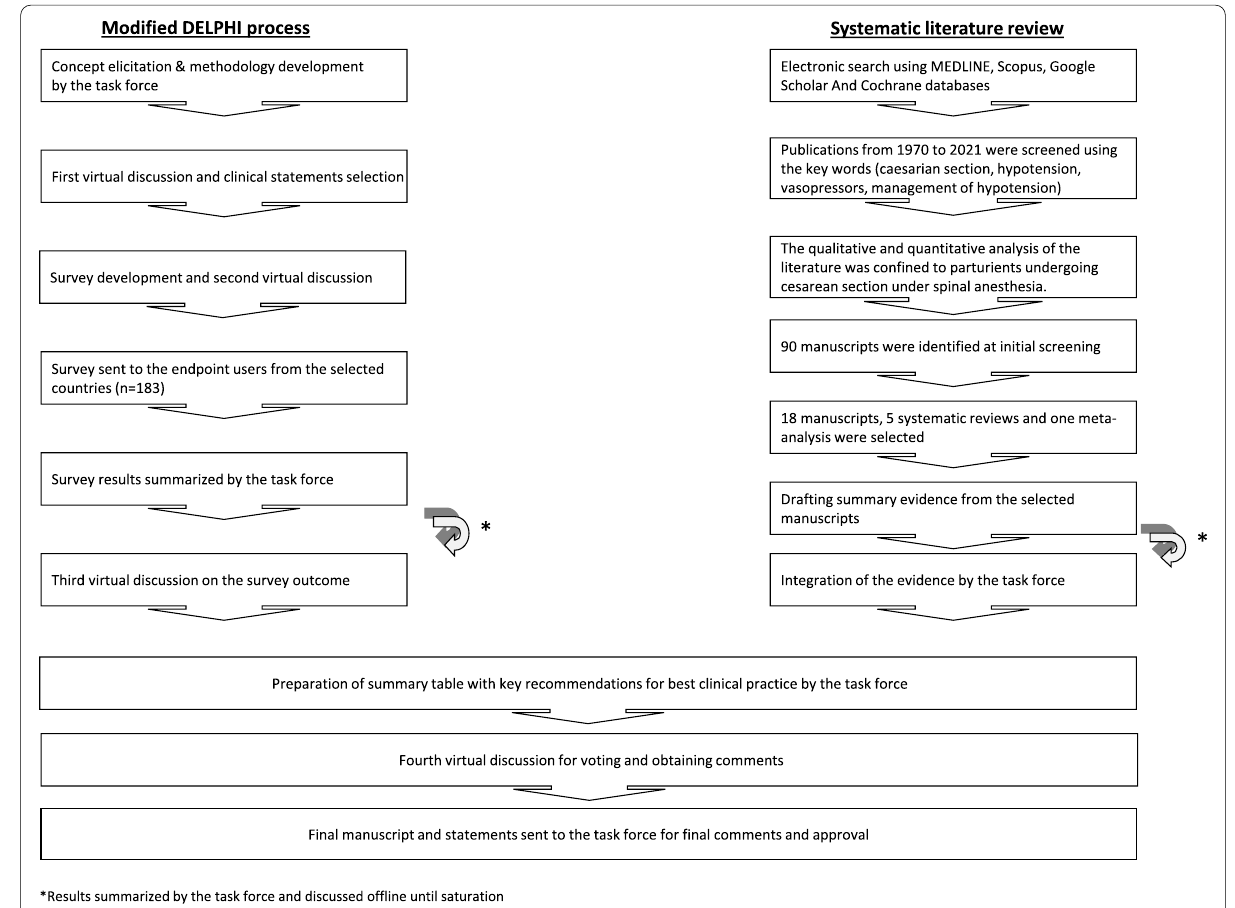
Fig. 1 Flow diagram of the consensus steps, including a systematic literature review and modified Delphi